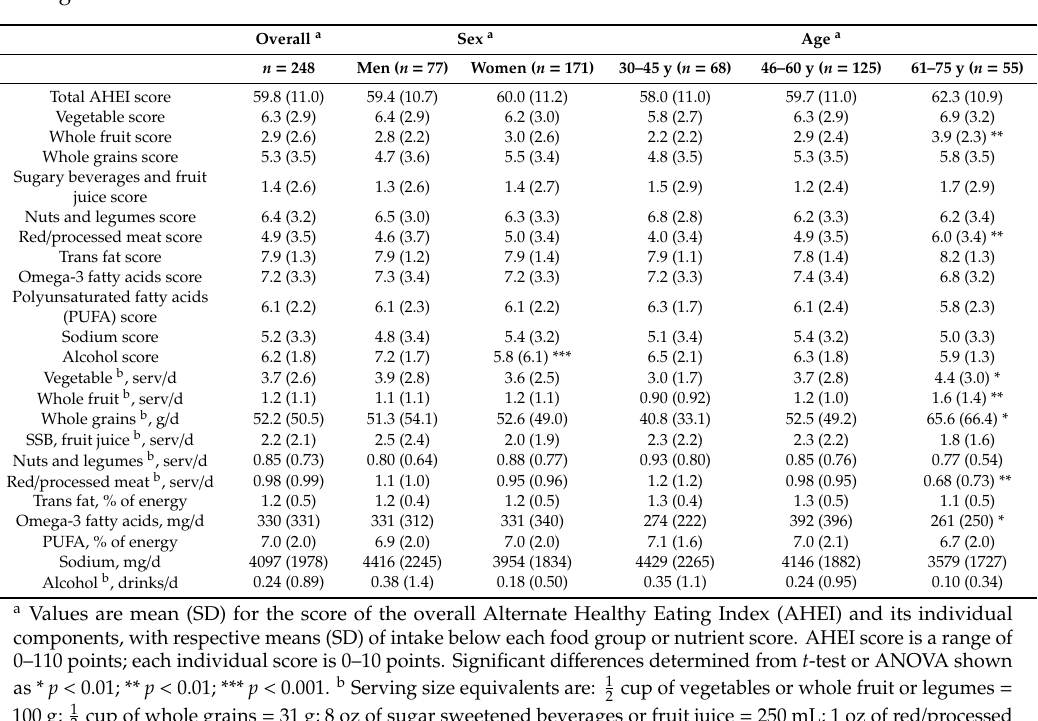
Table 4. Mean (standard deviation) of the Alternate Healthy Eating Index and its components in adults living in Puerto Rico.